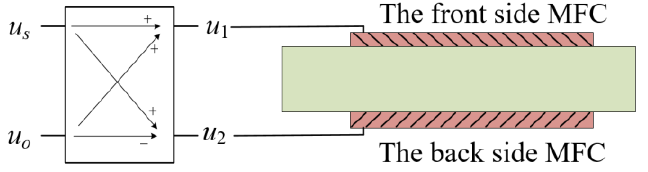
Figure 5. Voltage distributions for the two MFC actuators.